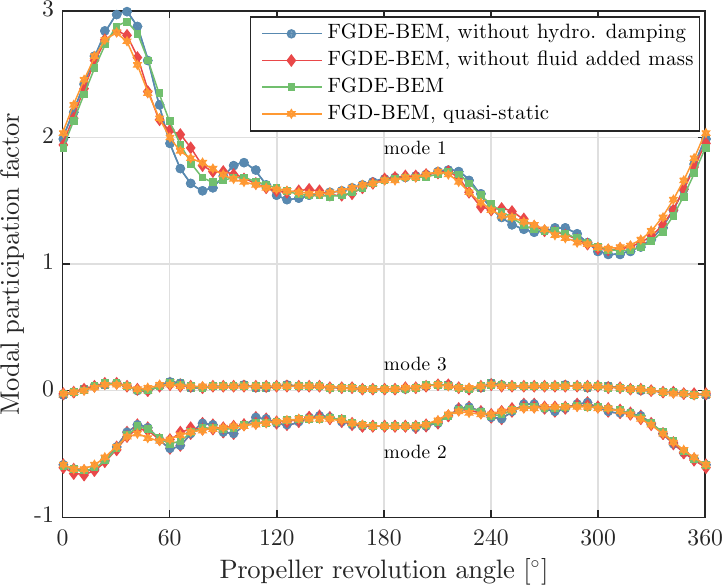
Figure 20. Modal participation for first three modes computed with the FGDE-BEM-FEM coupling with and without including the fluid added mass and hydrodynamic damping in the calculations, for the carbon–epoxy Seiun–Maru